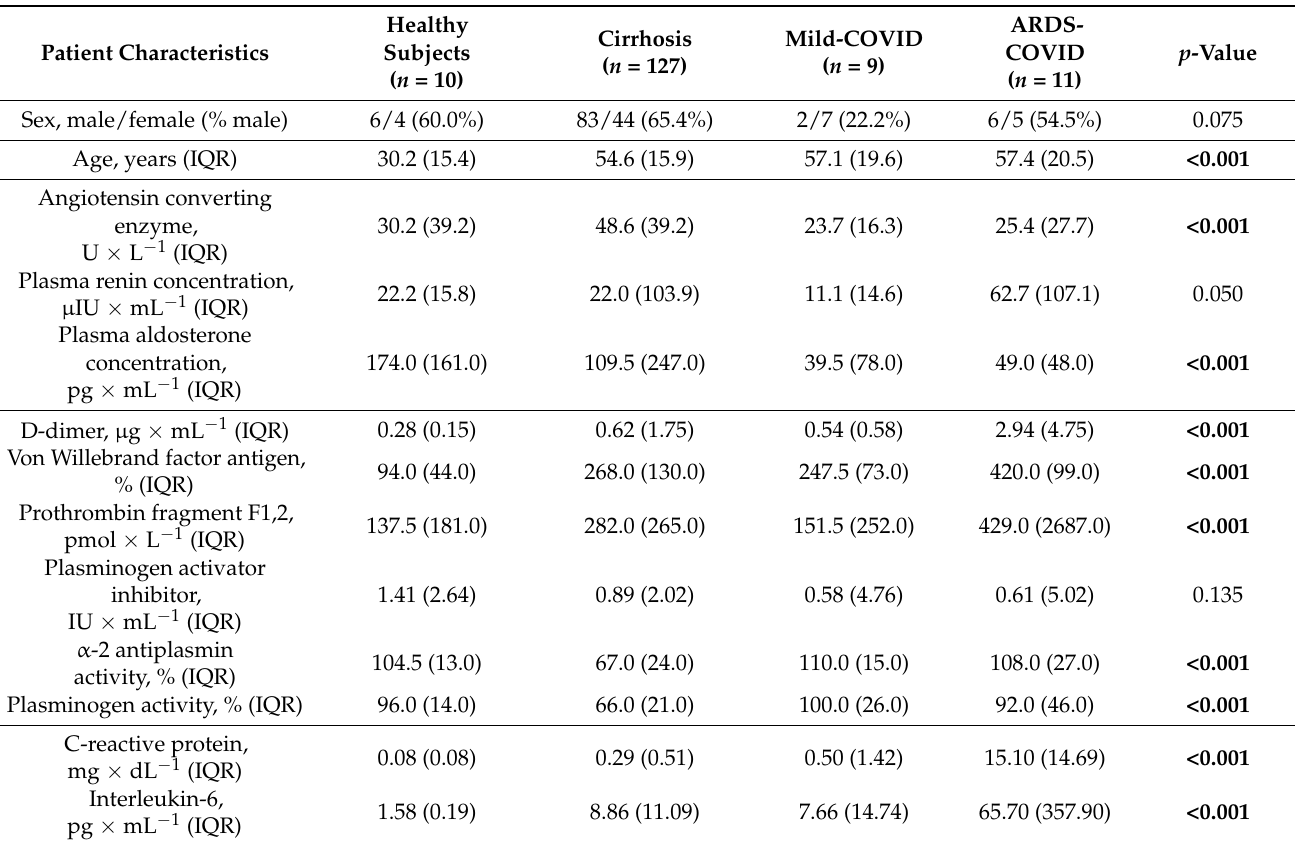
Table 2. Characteristics of healthy subjects and patients with cirrhosis, mild-COVID-19, and ARDS-COVID-19.